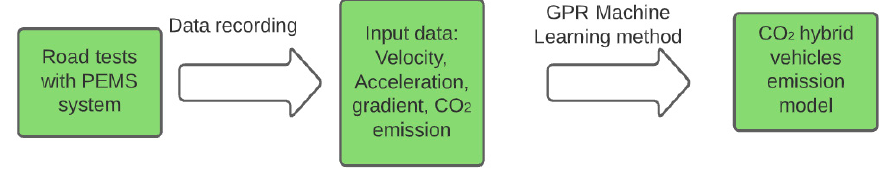
Figure 5. General overview of the emission model creation procedure sequence.